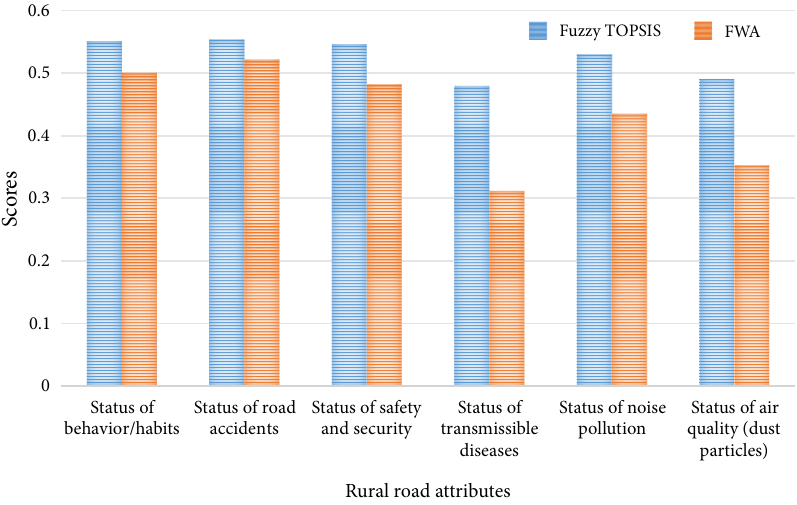
Figure 7. Attribute scores depicting their ranks for fuzzy TOPSIS and improved FWA